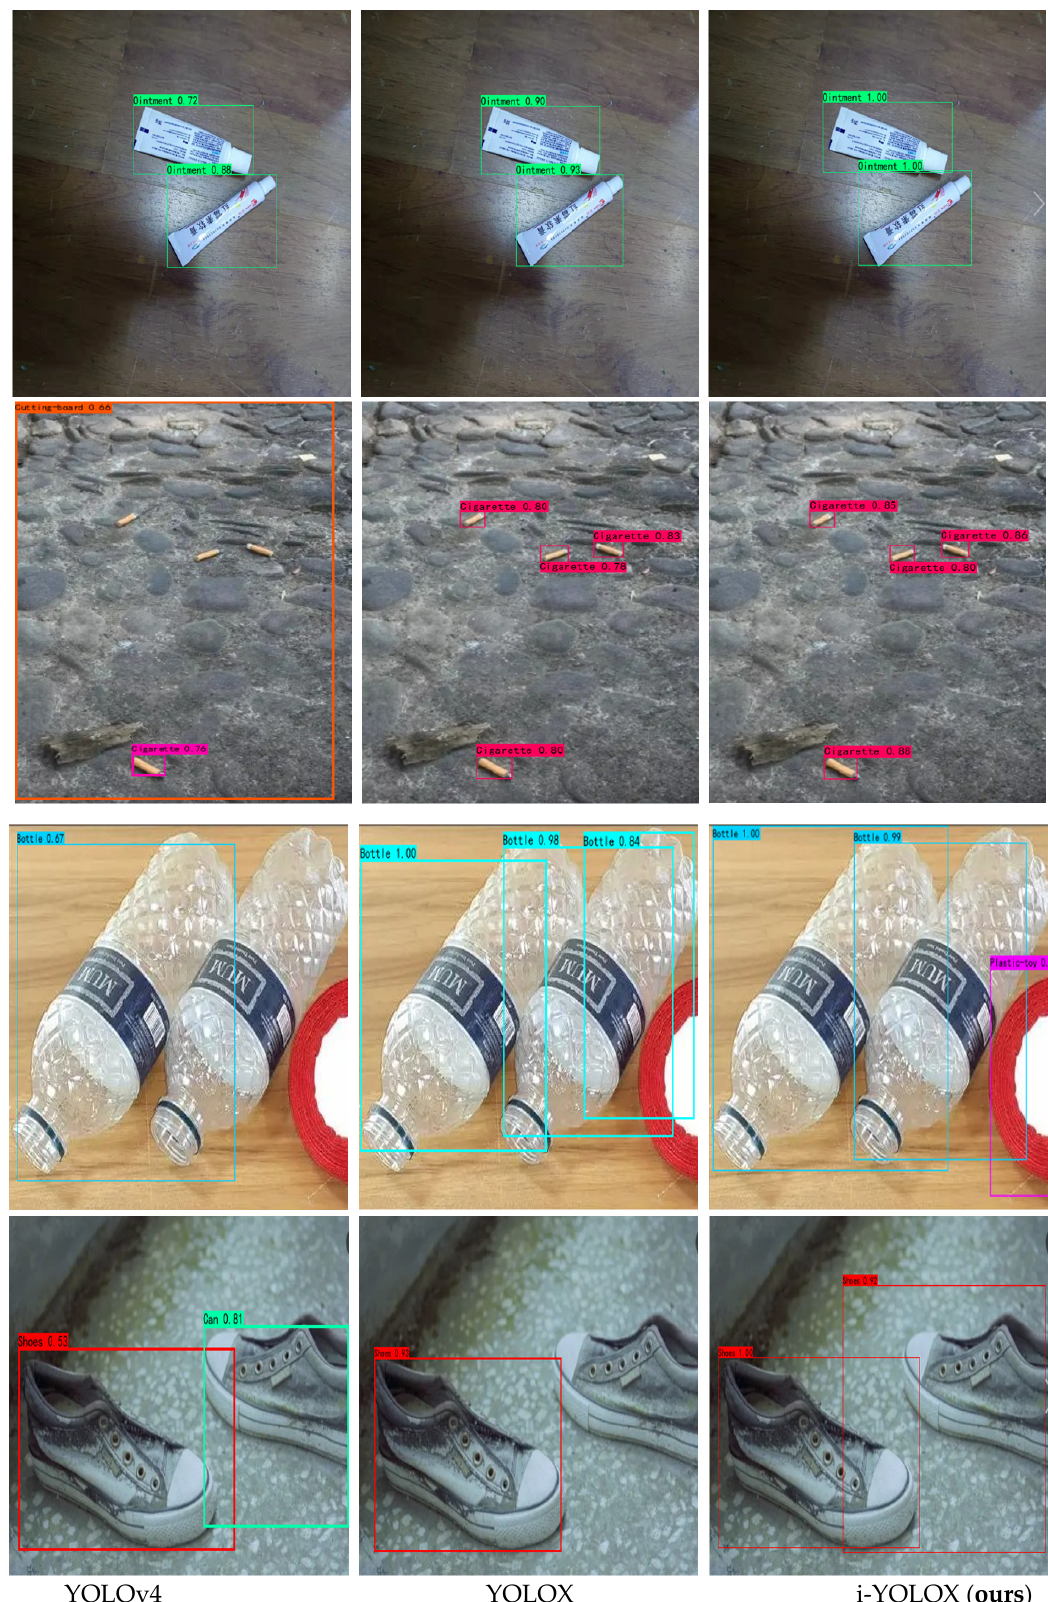
Figure 11. The detection results of test domestic trash images.